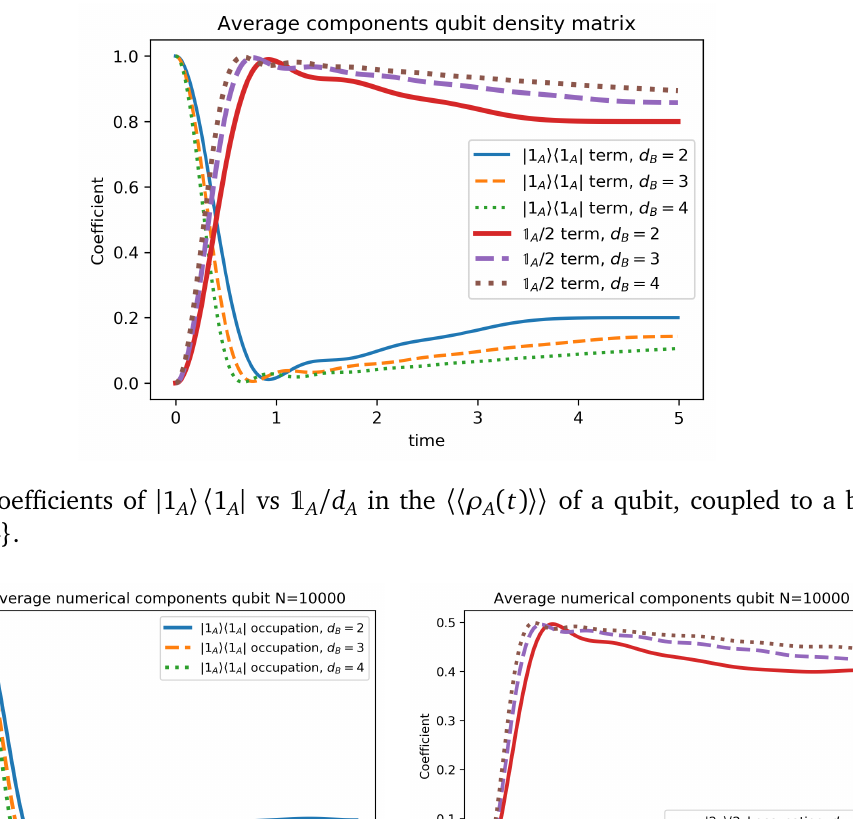
Figure 8: Numerically GUE-averaged 〉〈 1 | in ρ ( t ) coefficients of | 2 A A A of a qubit, coupled to a bath of ∈ { 2,3,4 } d B